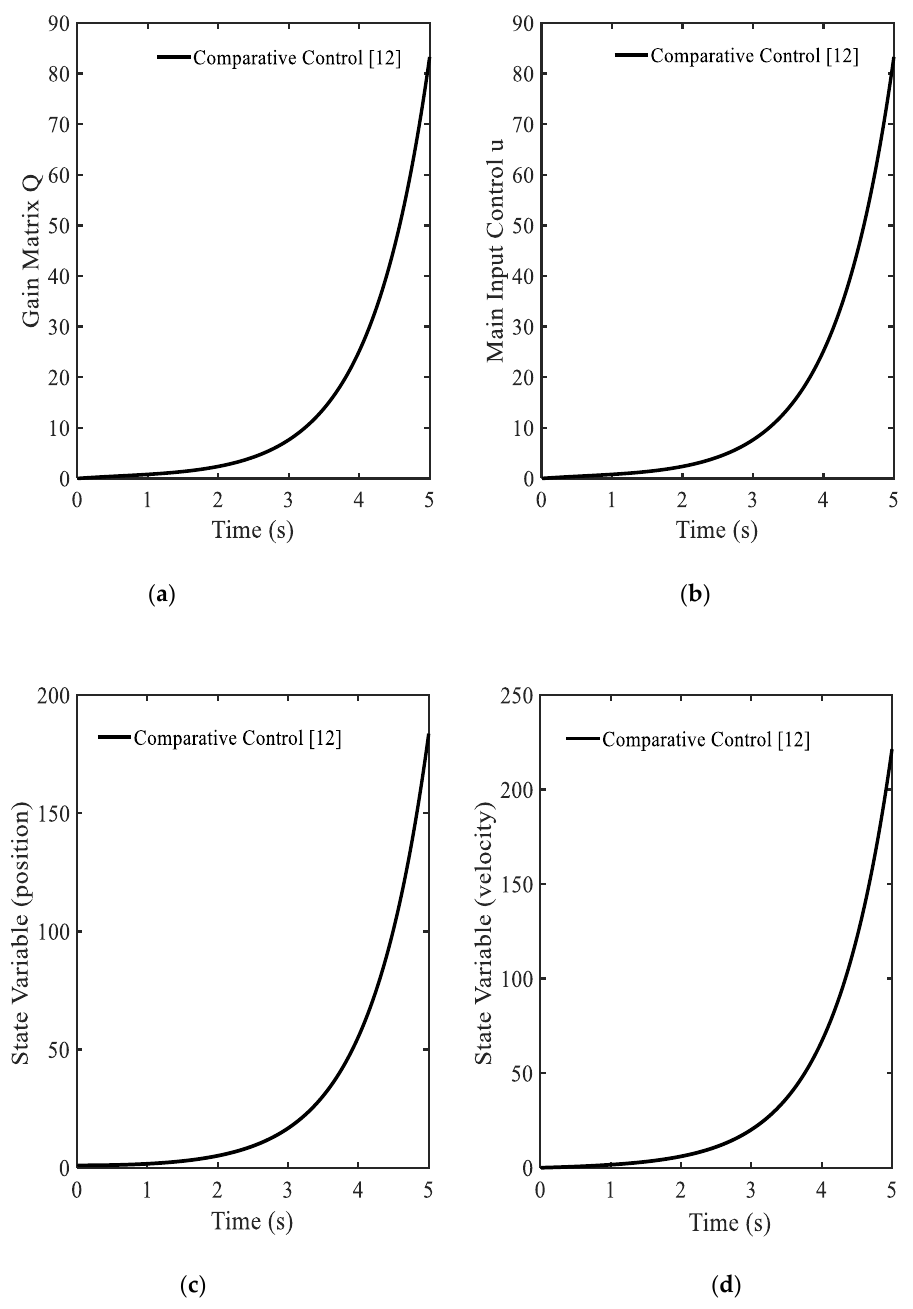
Figure 1. Simulation results of the comparative optimal controller in [12]: ( a ) gain function Q ∆ L ( t ) , ( b ) main control u ∗ ( t ) , ( c ) state variable (position) x e ( t ) , ( d ) state variable (velocity)